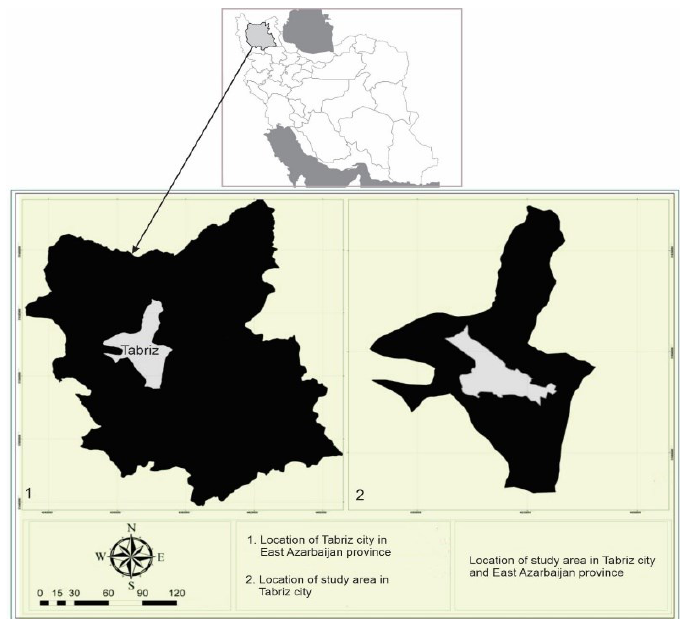
Fig. 1. Location of study